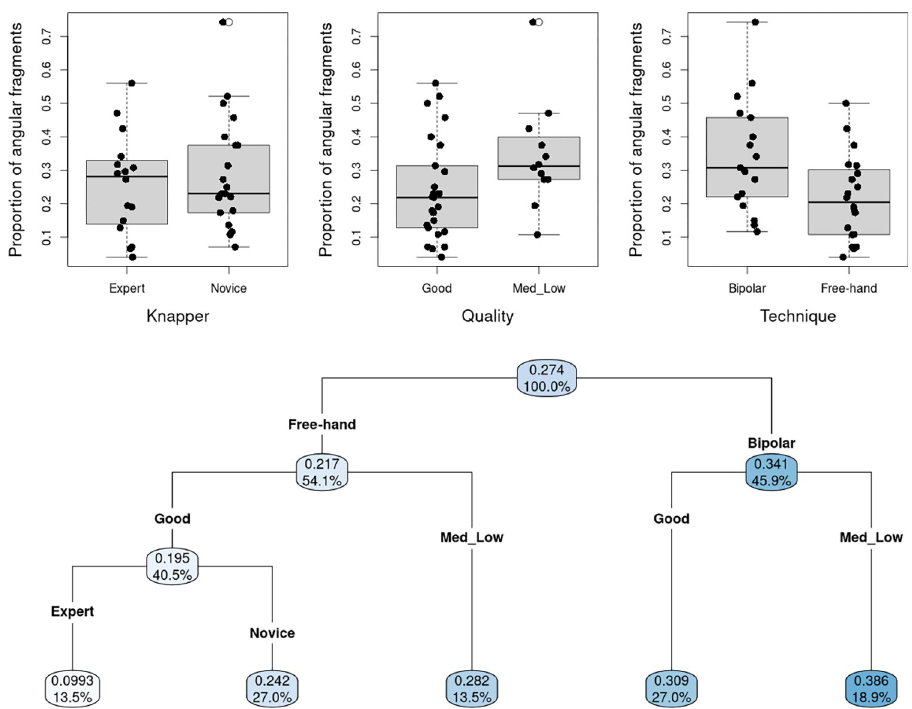
Fig 4. a. Boxplots and stripcharts for the impact of each factor on the proportion of angular fragments; b. Regression tree for the proportion of angular fragments, with knapping technique, raw material quality and knapping expertise as covariates. (In each node, the upper value is the empirical proportion observed for a given combination of factors; the "%" value indicates the percentage of the total sample size in this node).